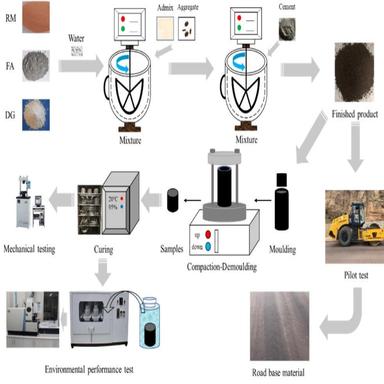
Preparation, test and application of road base material.